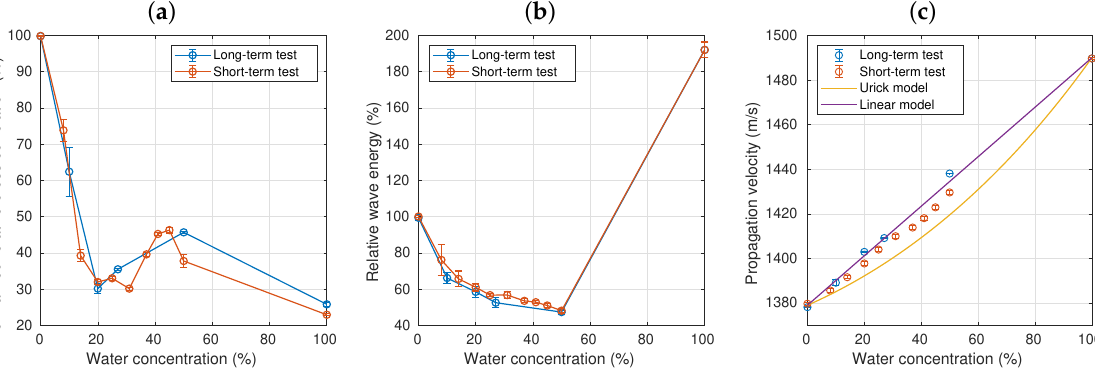
Figure 5. The experimental results as a function of the water concentration: ( a ) relative cross correlation, ( b ) relative wave energy, and ( c ) propagation velocity at 22 ± 0.2 ◦